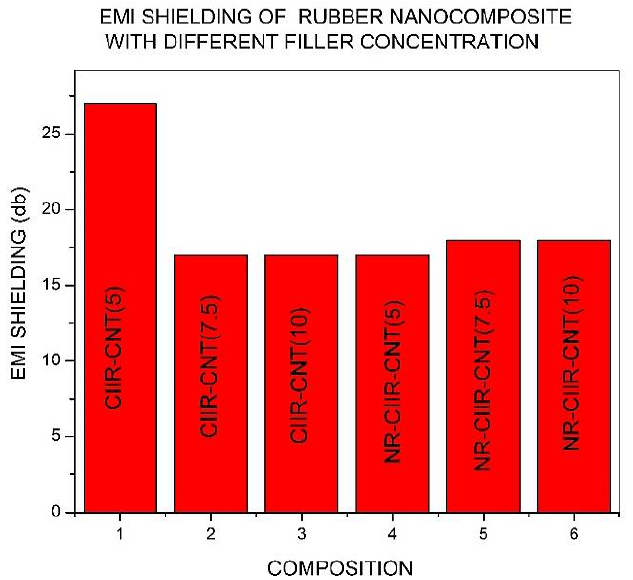
Figure 19. EMI shielding versus composition graph of rubber nanocomposite with different filler concentrations.